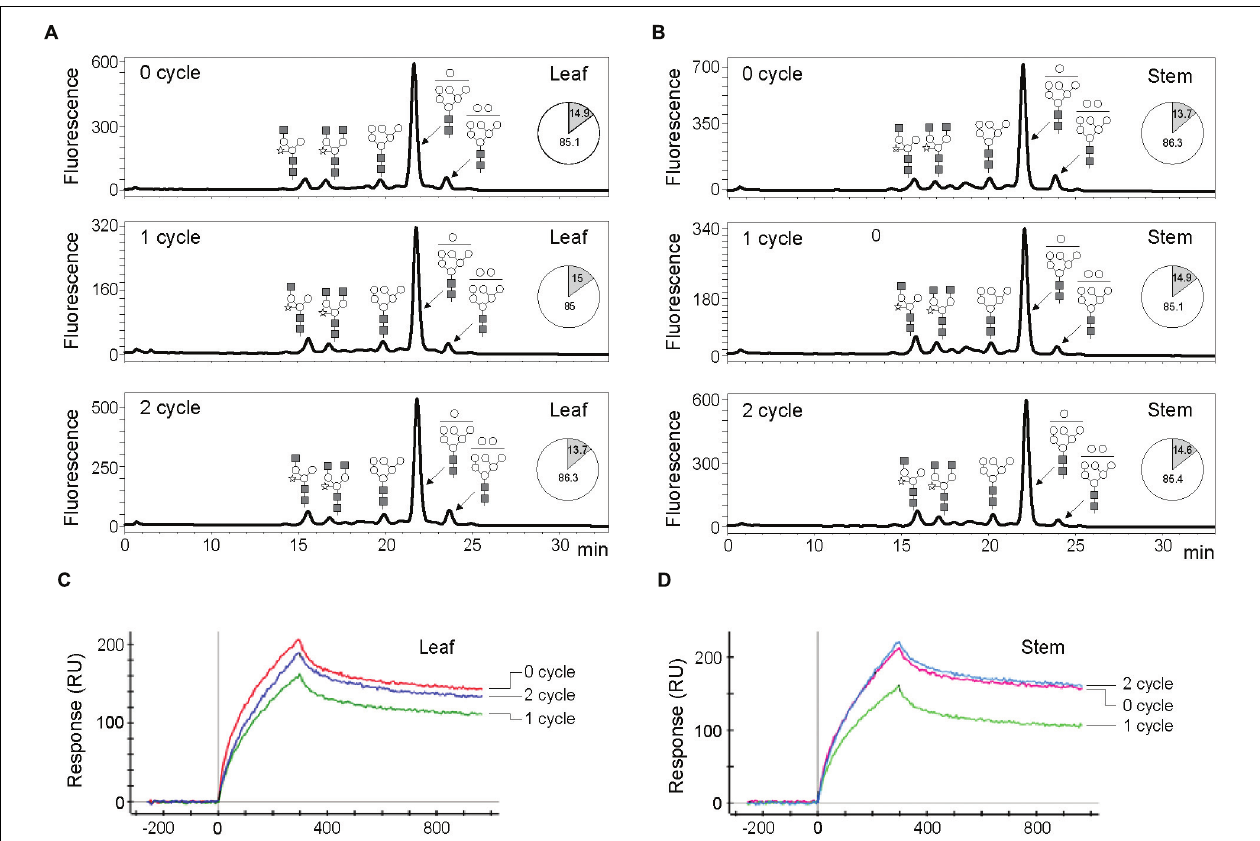
FIGURE 2 | Glycosylation and function analyses of mAb CO17-1A protein purified from leaves and stem of 0, 1, and 2 cycle plants. (A,B) Profiles of N -glycan from mAb P CO17-1A were analyzed using high performance liquid chromatography of the 2-AB labeled glycans. (A) Glycan structure profiles of mAb P CO17-1A purified from leaf of 0, 1, and 2 cycle plants. (B) Glycan structure profiles of mAb P CO17-1A purified from stem of 0, 1, and 2 cycle plants. GlcNAc, mannose, and xylose are depicted using black square, white circle, and white star, respectively. The ratios of oligomannose (white) and plant-specific (gray) glycans of mAb P CO17-1A in leaves and stem of 0, 1, and 2 cycle plants were shown in a pie chart. Binding affinity of mAb CO17-1A purified from leaves (C) and stem (D) of 0, 1, and 2 cycle plants to GA733 antigen using surface plasmon resonance (SPR). Purified mAb P CO17-1AK from the leaves of 0, 1, and 2 cycle plants was incubated with the GA733 adsorbed biochip (C) . Purified mAb P CO17-1A from the stem of 0, 1, and 2 cycle plants was incubated with the GA733 adsorbed biochip (D) .